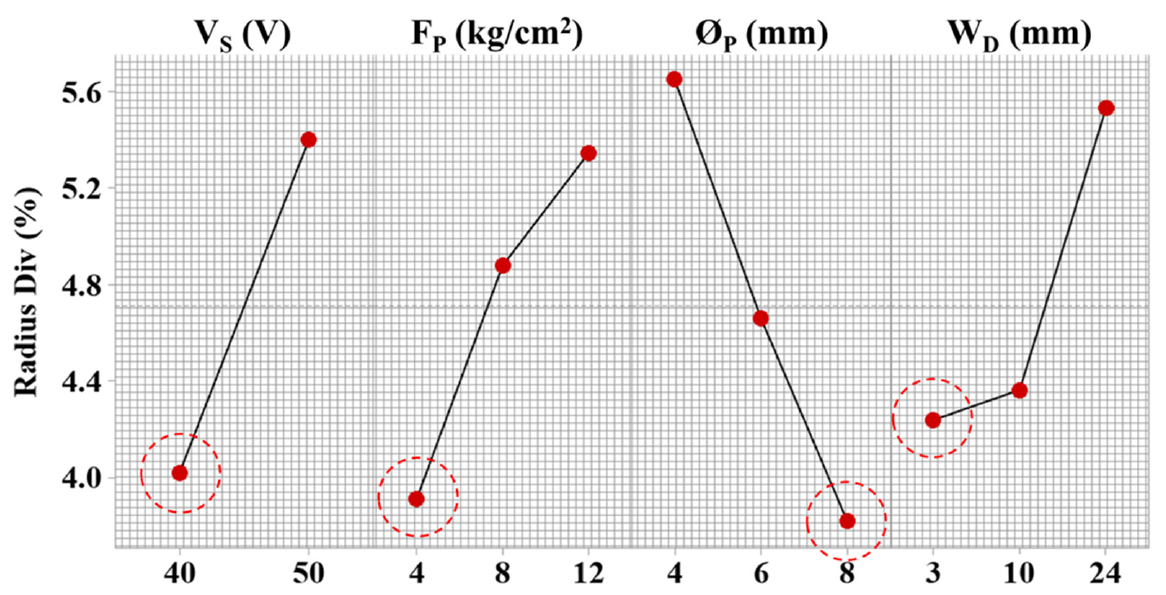
Figure 13. Parametric effects on cylindricity error of complex profiles machining and red circles indicating desired parametric level.